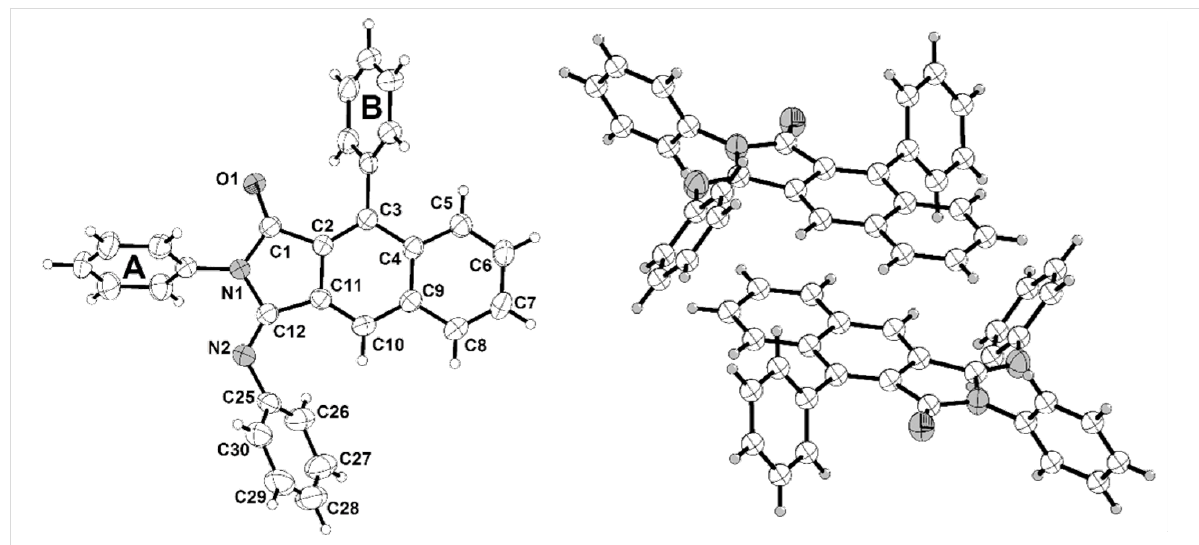
Figure 2: The ORTEP-type plot of the crystal structure 5 (left) and a centrosymmetric dimer formation by π – π interactions (right) (ellipsoids are drawn at the 40% probability level).